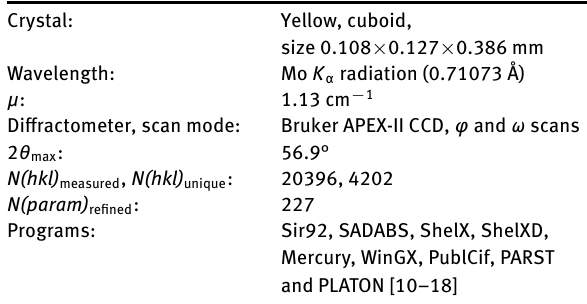
Table 1: Data collection and handling.